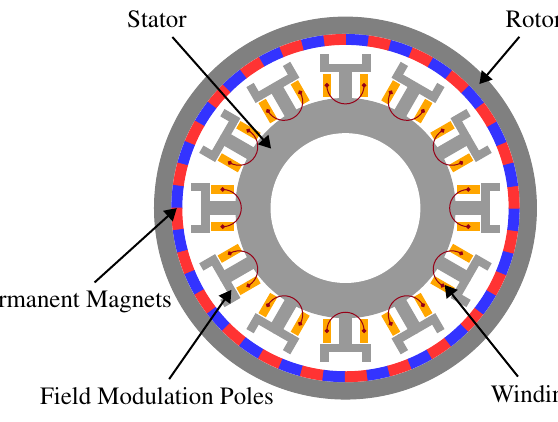
Figure 22. Topology of an outer-rotor vernier permanent-magnet motor